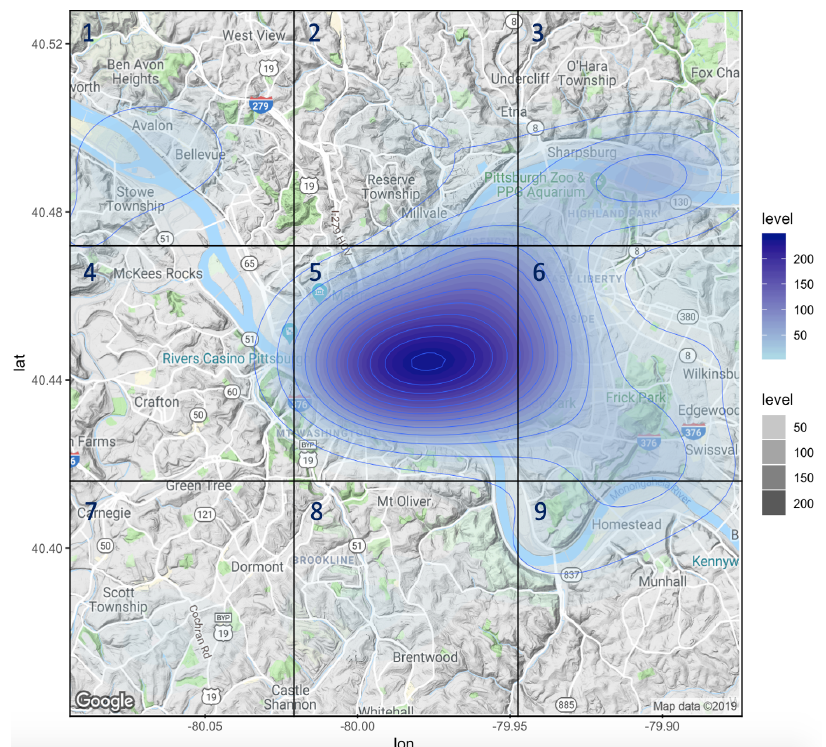
Figure 5. Heat map of critical nodes across all